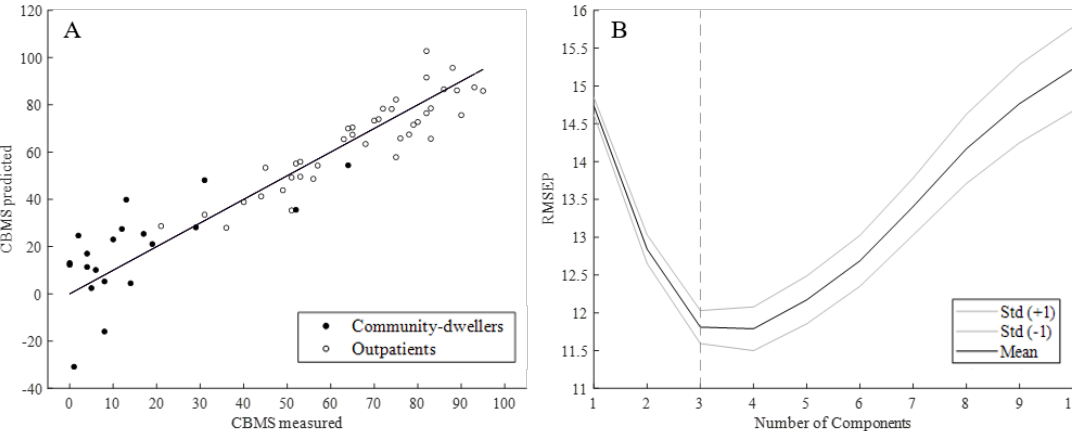
Figure 4. ( A ) Predicted vs. measured CBMS total score from iTUG for outpatients and community-dwellers; ( B ) Mean root mean square error of prediction (RMSEP) +/− one standard deviation across 10 components.